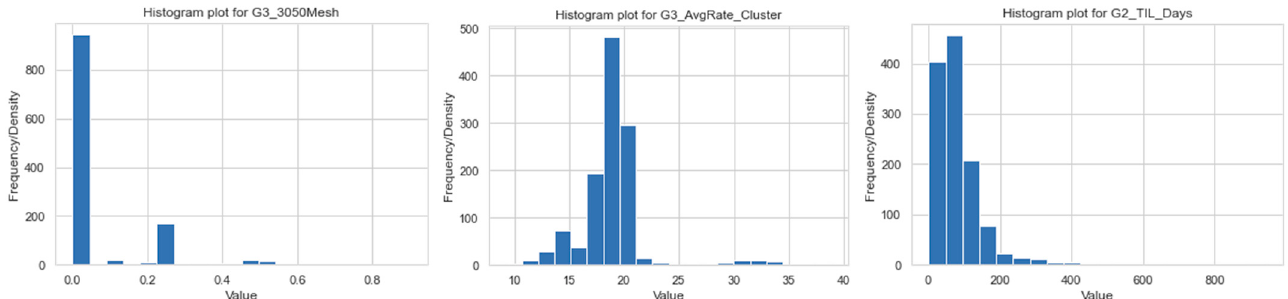
Figure A1. Model parameter distributions from top left to right (number of clusters per stage; cluster spacing; water loading per cluster; proppant loading per cluster, 100 mesh; 40/50 mesh; 30/50 mesh; average rate per cluster; time in-line).